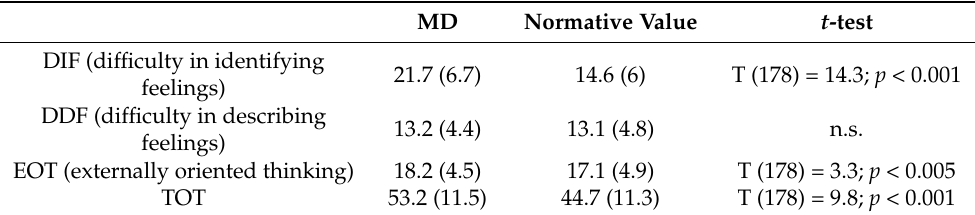
did not show any significant difference between A and NA